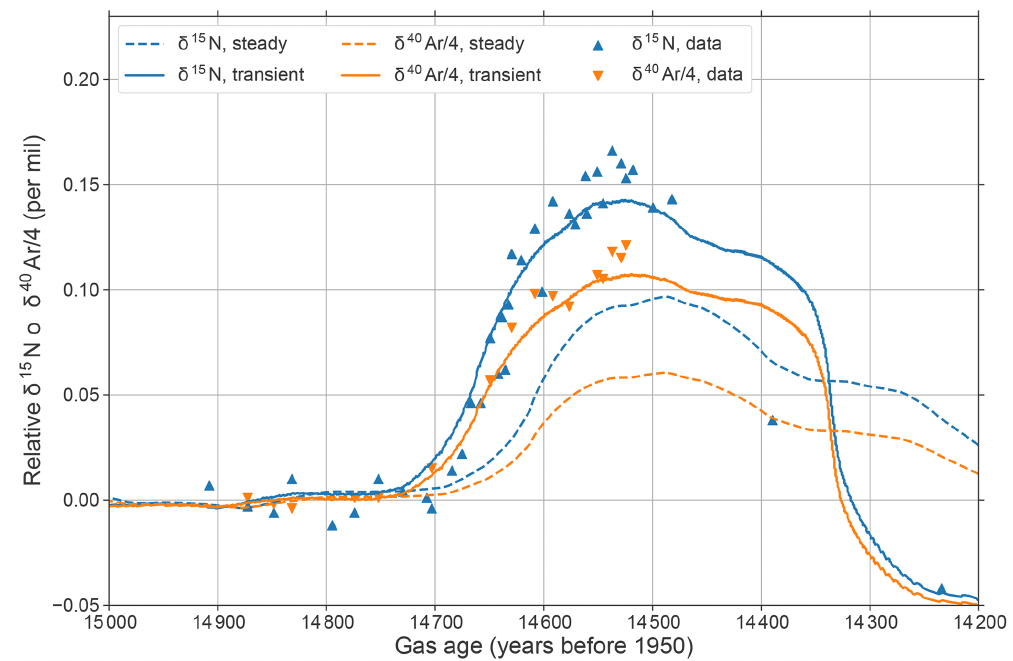
Figure 5. As in Fig. 4, but zoomed into the Bølling transition. Additionally, for this figure we have shifted the y axis to match the transient and steady-state simulations with the data leading into the Bølling transition to highlight the magnitude of the modeled changes compared to the